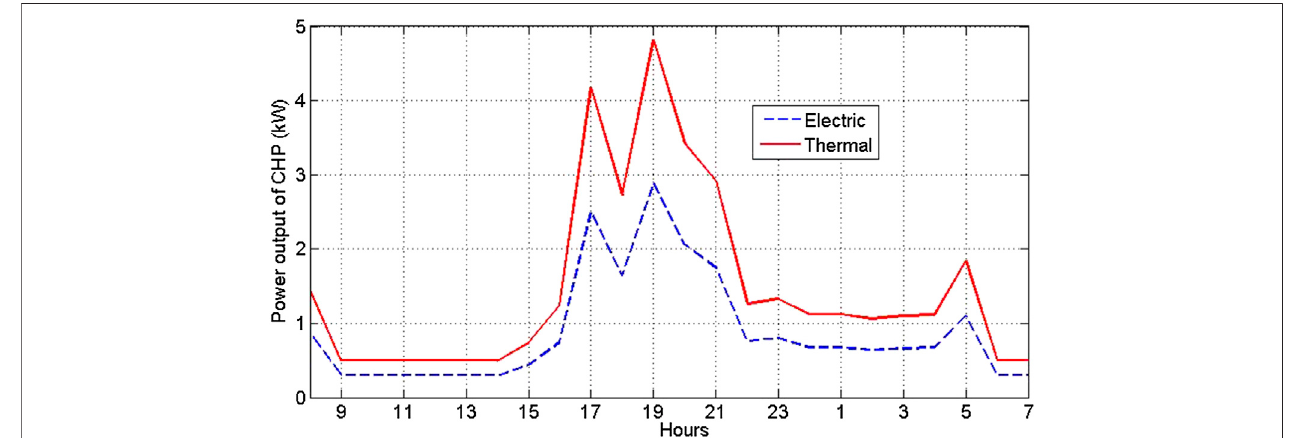
FIGURE 6 | Optimal state of the